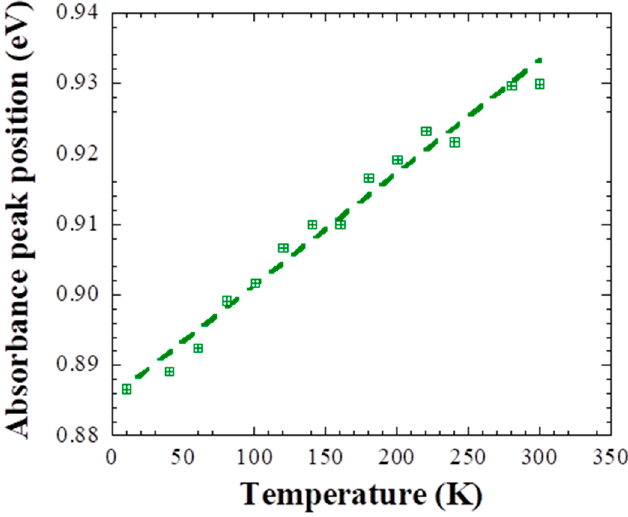
Figure 5. Absorbance peak versus temperature. The dashed line is a linear fit of the data.